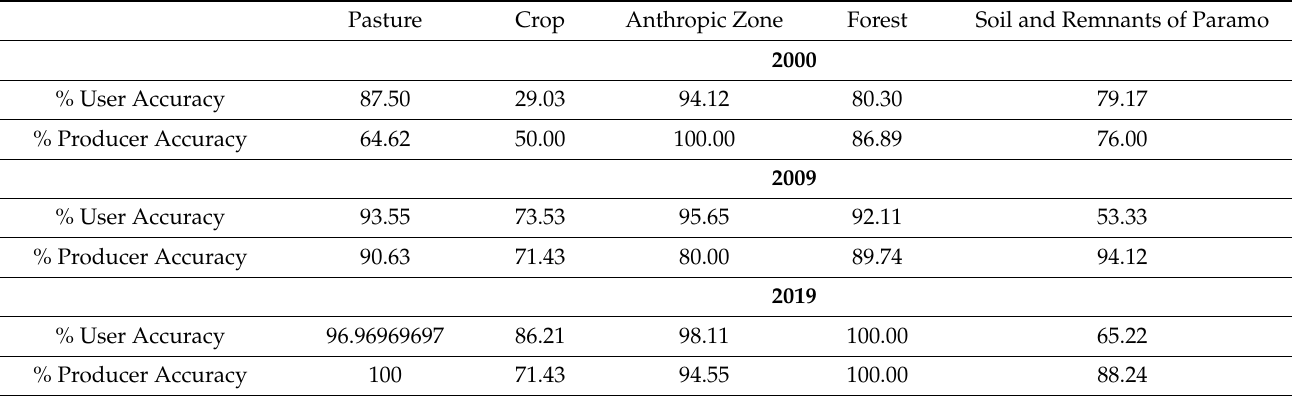
Table 2. Accuracy evaluation of the supervised classification.